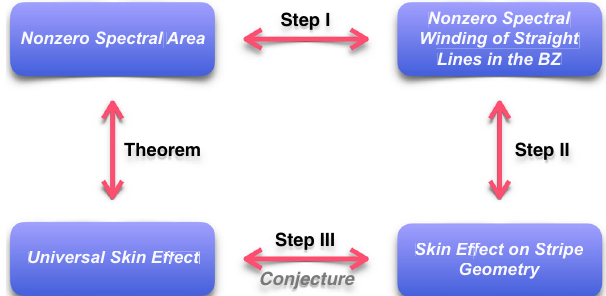
Fig. 2 The sketch of the proof of the theorem. The fi rst step connects the nonzero spectral area and nonzero spectral winding number along some direction in the BZ. The latter means the Hamiltonian exhibits the skin effect under the corresponding stripe geometry, which is proved in the second step. The skin effect on stripe geometry further reveals the universal skin effect, relying on a conjecture in the third step.